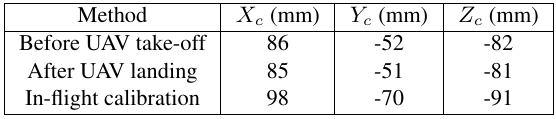
Table 1: Different estimates of values of the lever-arm